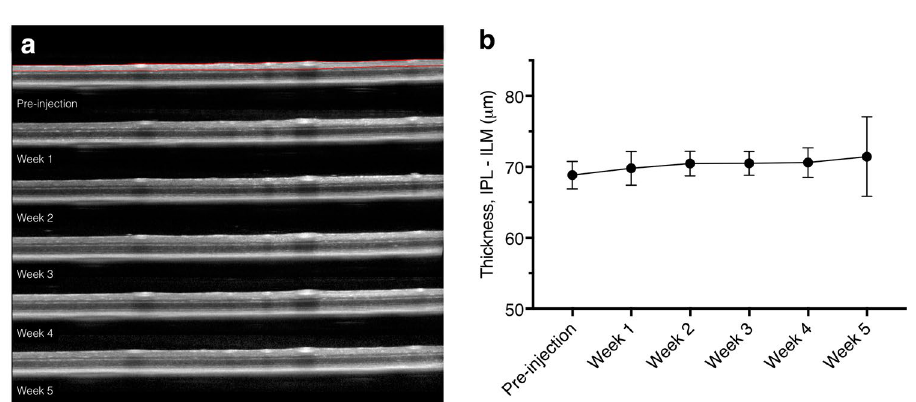
Figure 5. Longitudinal optical coherence tomography (OCT) scans of an eye following AAV2-DCX- GFP injection. ( a ) Representative OCT scans in one animal obtained from the raster scanning pattern at pre-injection and at weeks 1, 2, 3, 4 and 5 after intravitreal injection. Red lines in pre-injection scan show segmentation of the inner retina (from inner plexiform layer to inner limiting membrane). ( b ) Mean inner retinal thickness measurement for the injected eyes measured longitudinally. No statistically significant differences were found between any of the time points. Error bars represent 95% confidence interval; n =